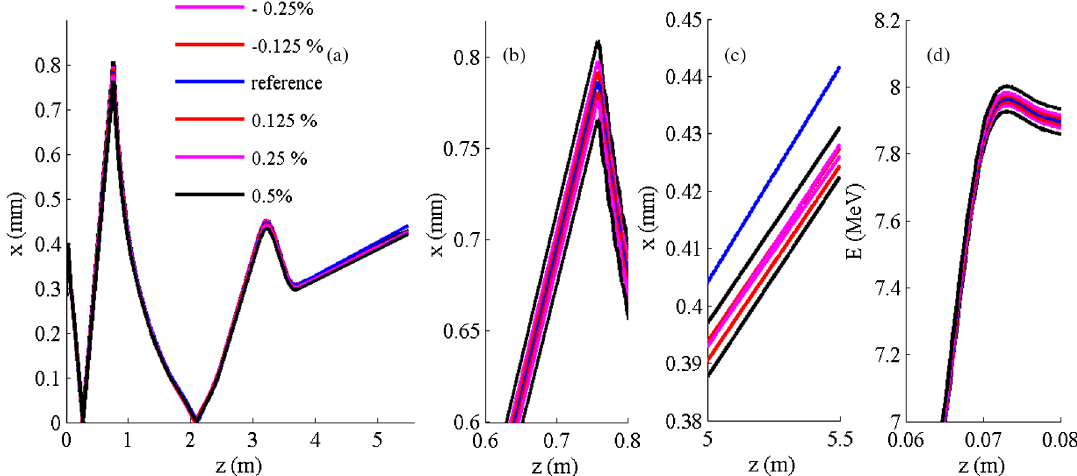
FIG. 33. (a) Simulated trajectories along beamline for various changes in the rf field amplitude — the reference trajectory corresponds to a 200 MV = m cathode field, a laser offset of 300 μ m and an 88 MV = m acceleration gradient. (b – d) Zoomed-in views of the trajectories at two z locations and the beam energy variation just after the gun.